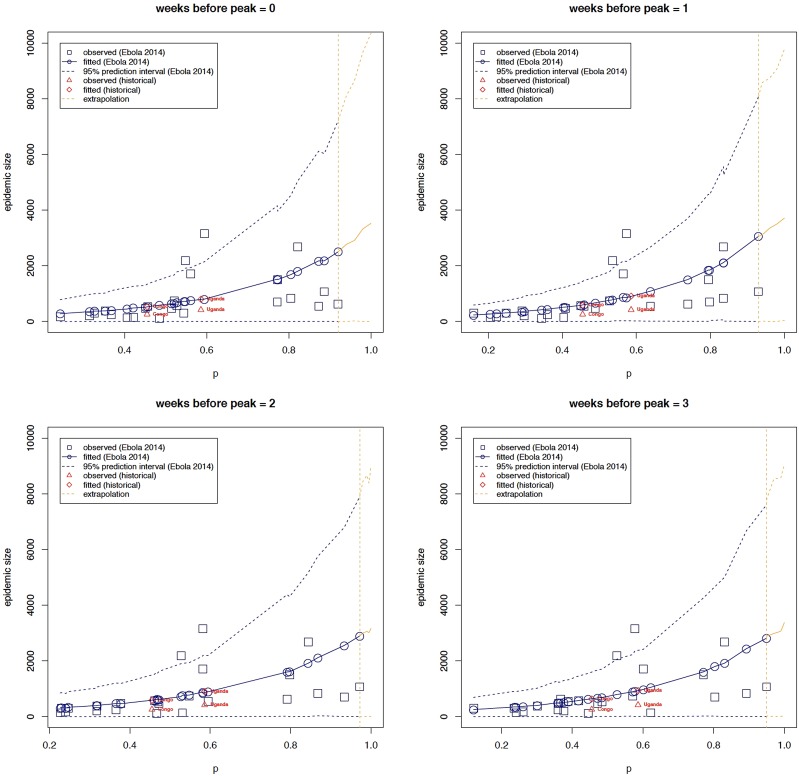
The relationship between epidemic size and the scaling of epidemic growth parameter p across 24 administrative-level Ebola outbreaks comprising at least 7 weeks of epidemic growth, for varying ascending phase lengths. The relationship between epidemic size and scaling of epidemic growth parameter is consistent for two past Ebola outbreaks that occurred in Congo in 1976, which affected the village of Yambuku [18] and in Uganda (2000), which mostly affected the district of Gulu [19]. The relationship was extrapolated from our highest estimate of p (around 0.93; vertical dashed line) to p = 1.